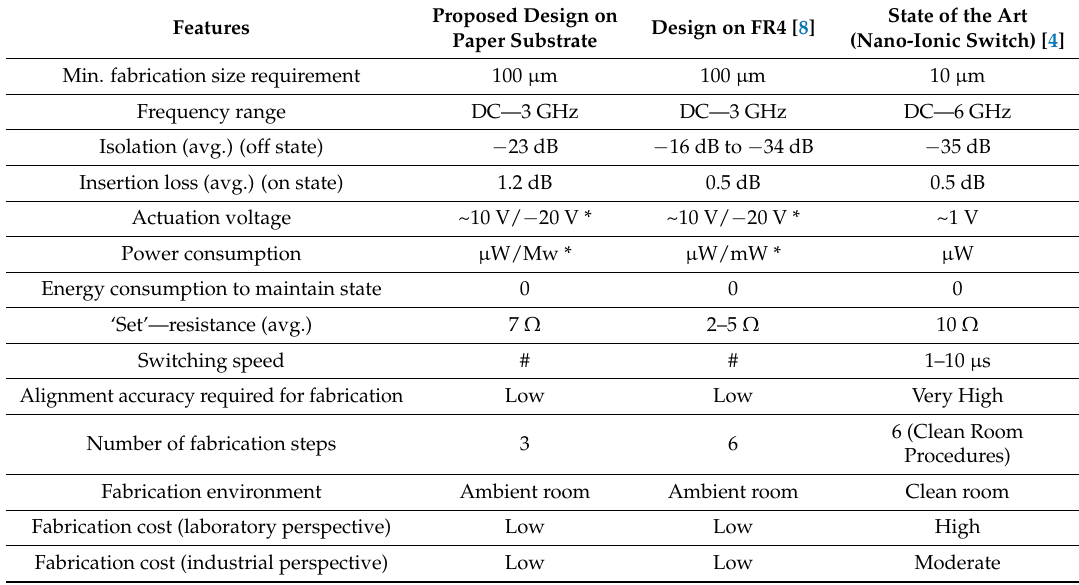
Table 1. Comparison of proposed device to the state-of-the-art.